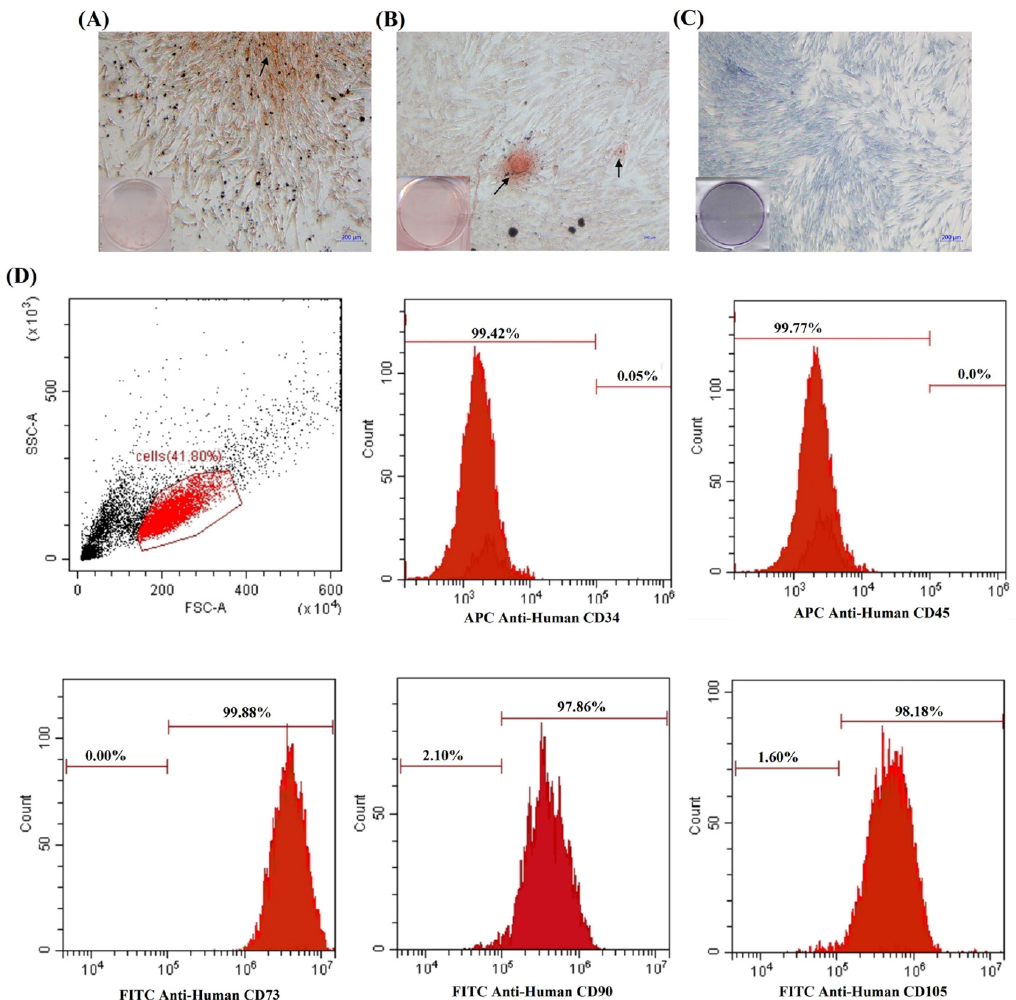
Figure 3. Isolation, morphological observation and flow cytometry analysis of hDPSCs. ( A ) Mineralized deposits identified by Alizarin Red staining in cells grown in osteogenic medium. ( B ) Adipogenic-induced cells were stained with Oil Red O. ( C ) Colony-forming fibroblastic units (CFU-F). ( D ) Histograms from flow cytometry analysis of cell surface markers. The hematopoietic marker, CD34 and CD45 positive are less than 20%. The MSC markers, CD73, CD 90, and CD105 positive are more than